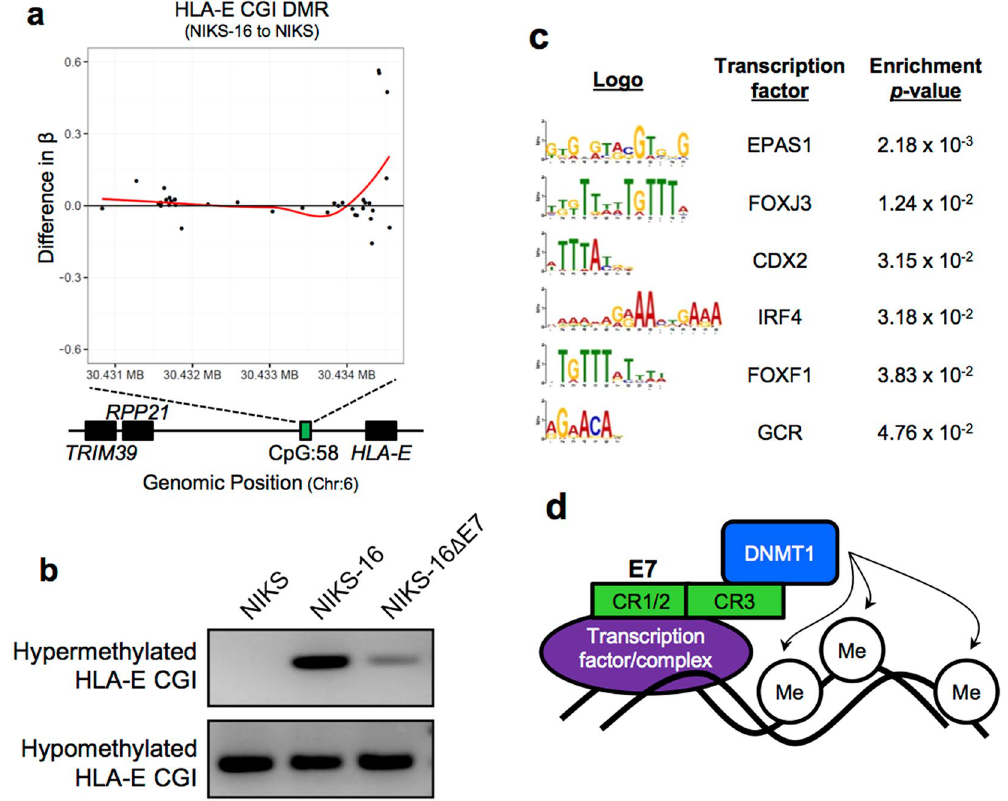
Figure 4. HPV16 E7 is necessary for hypermethylation at a distal HLA-E CpG island. ( a ) The difference in methylation ( β ) of all probed CpG dinucleotides in the HLA-E CpG island (CGI, chr6:30,434,030–30,434,730) between NIKS and NIKS-16 cells is shown. Positive and negative β indicates increased or decreased methylation in NIKS-16 cells compared to NIKS cells, respectively. The red line represents a locally weighted scatter plot (LOESS) regression curve, showing the trend of differences in β values (Y) along the genomic position (X). ( b ) Methylation specific PCR (MSP) products were separated in 2% agarose gel to evaluate the methylation status of the HLA-E CGI using bisulfite-converted gDNA from NIKS, NIKS-16, and NIKS-16 Δ E7 cells and primers listed in Table S7. ( c ) Sequence logos of enriched transcription factor (TF) binding motifs are shown. 100 bp regions flanking E7 sensitive DMRs (comparing NIKS to NIKS-16 cells, p < 0.04, count 185) were assessed for enrichment of TF binding motifs using MEME Suite software and nucleotide frequencies in the submitted sequences as background (enrichment p < 0.05). ( d ) Schematic diagram of the potential mechanism of targeted E7-induced DNA methylation. E7 binds transcription factors (or complexes) through its CR1/2 domain and DNMT1 through its CR3 domain, leading to hypermethylation near specific transcription factor binding